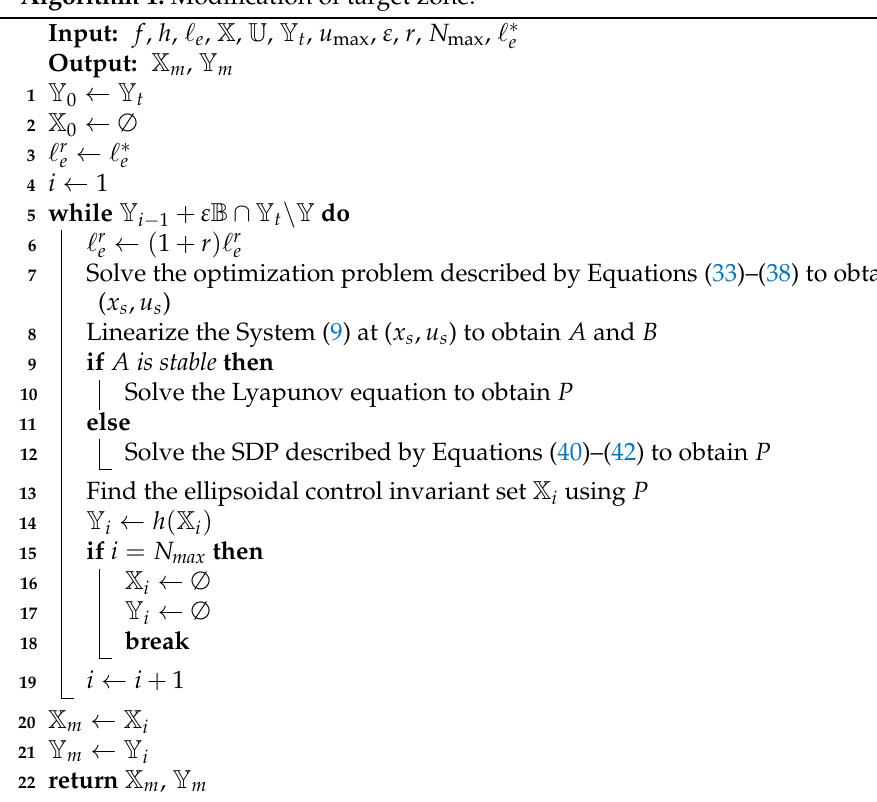
Algorithm 1: Modification of target